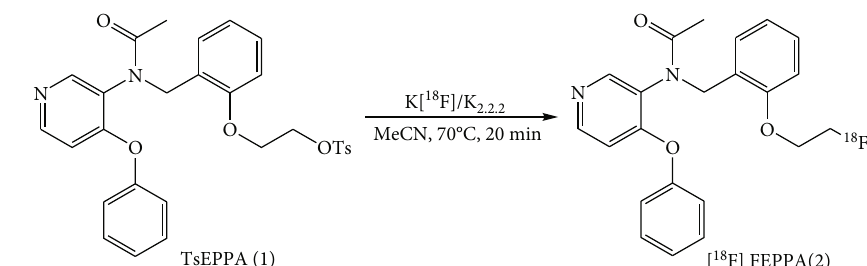
module for the [ 18 F]FEPPA (2) FN